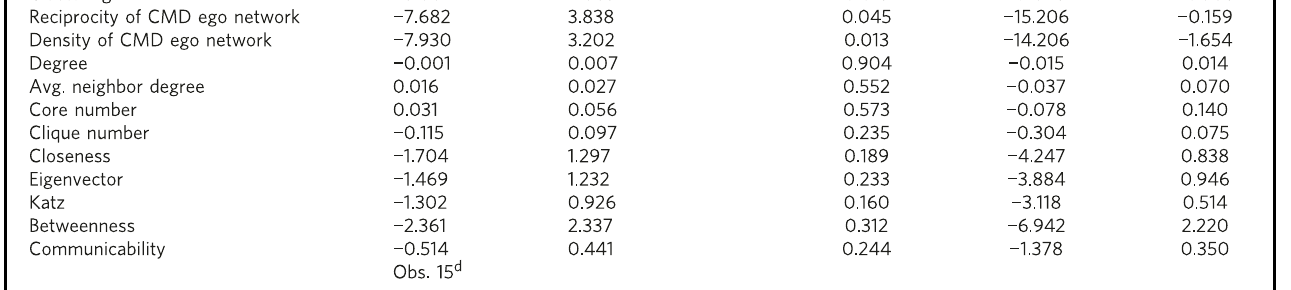
NATURE COMMUNICATIONS | DOI: